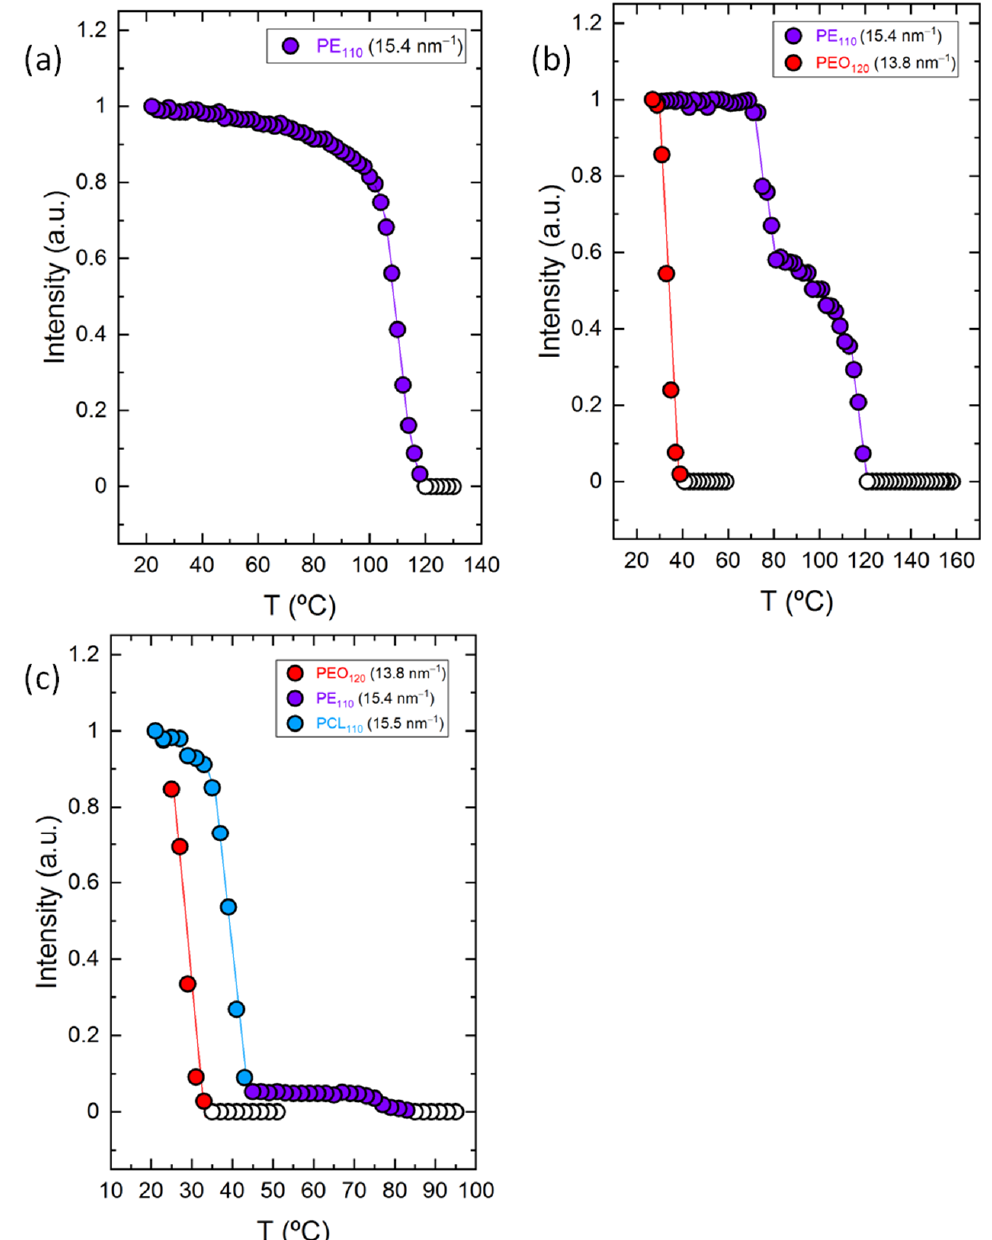
Figure 6. Normalized WAXS intensities as a function of temperature calculated from WAXS data represented in Figure 5 for ( a ) PE 7.1 (PE 110 (15.4 nm − 1 )), ( b ) PE 327.1 - b -PEO 6815.1 (PE 110 (15.4 nm − 1 ) and PEO 120 (13.8 nm − 1 )), and ( c ) PE 227.1 - b -PEO 4615.1 - b -PCL 3210.4 (PEO 120 (13.8 nm − 1 ), PE 110 (15.4 nm − 1 ) and PCL 110 (15.5 nm − 1 )) with colored data points and lines indicating crystallization of the corre- sponding blocks. Empty data points correspond to the molten